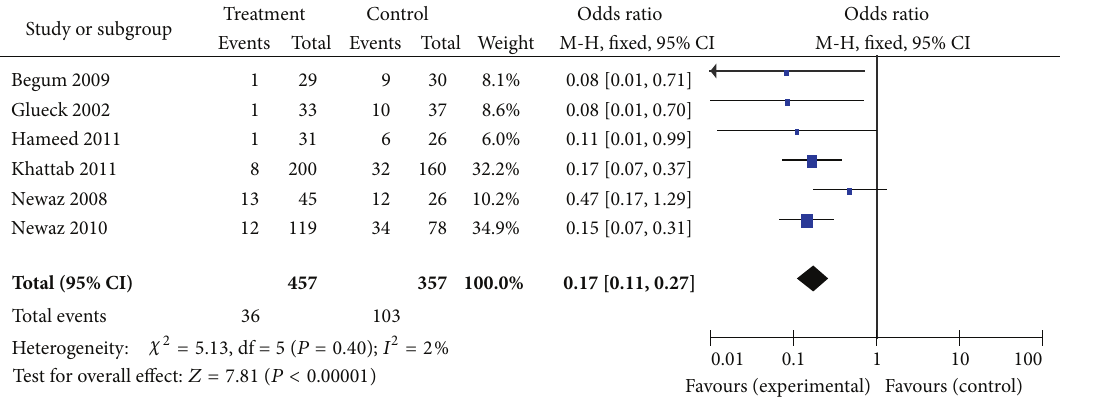
Figure 4: The meta-analysis of the odds ratio for gestational diabetes in the studies with PCOS as control.